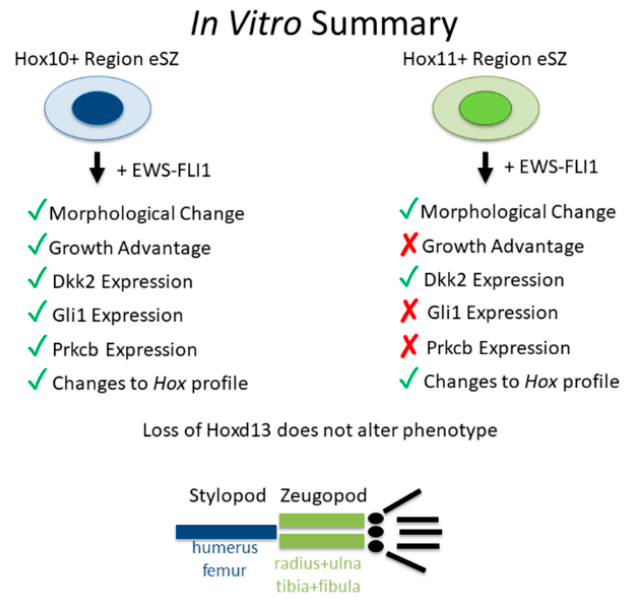
Figure 6. Summary of in vitro data.